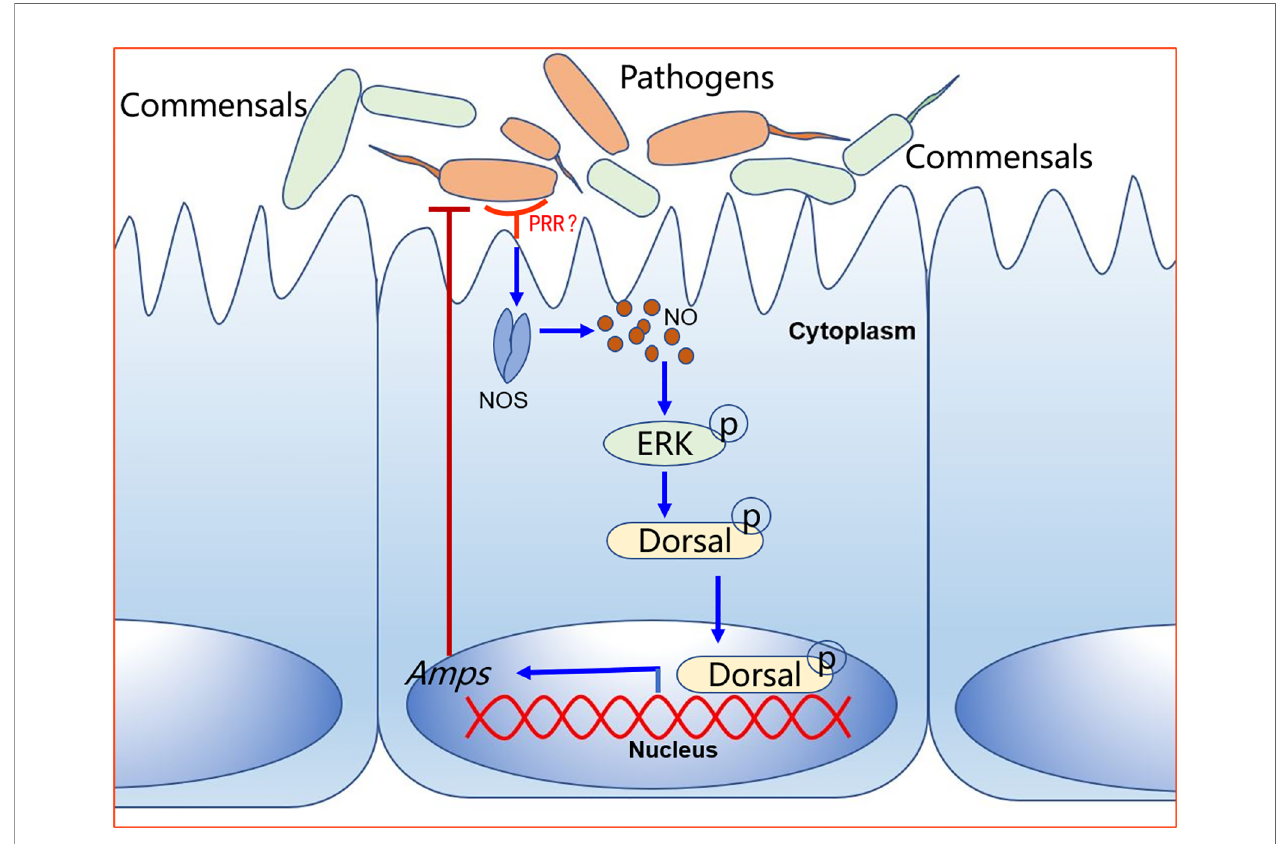
FIGURE 9 | A model for NO signaling in intestinal antibacterial immunity after oral infection of shrimp by V. anguillarum . The pattern recognition receptor on the surface of intestinal cells recognizes pathogen-associated molecular patterns on pathogens and activates signaling. The host-pathogen interactions upregulate NOS in the intestine tissue to release NO, which activates a signaling cascade that leads to the expression of AMPs to defend against